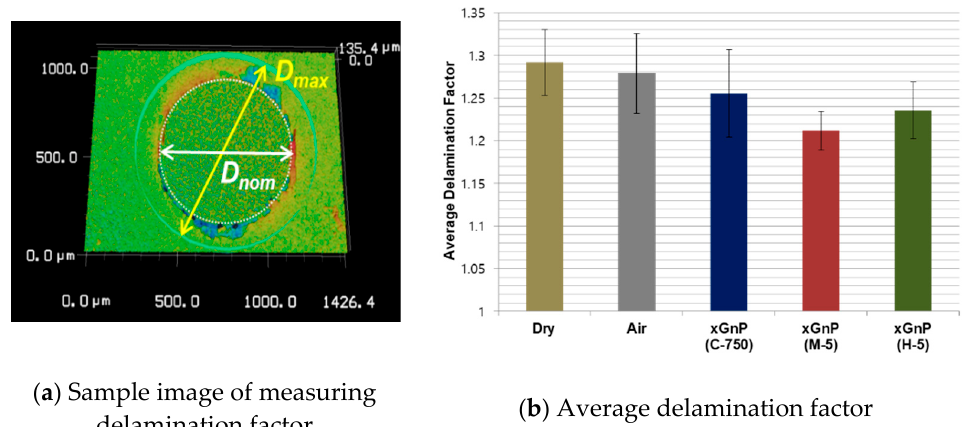
Figure 10. Sample images for calculating delamination and average delamination factor.